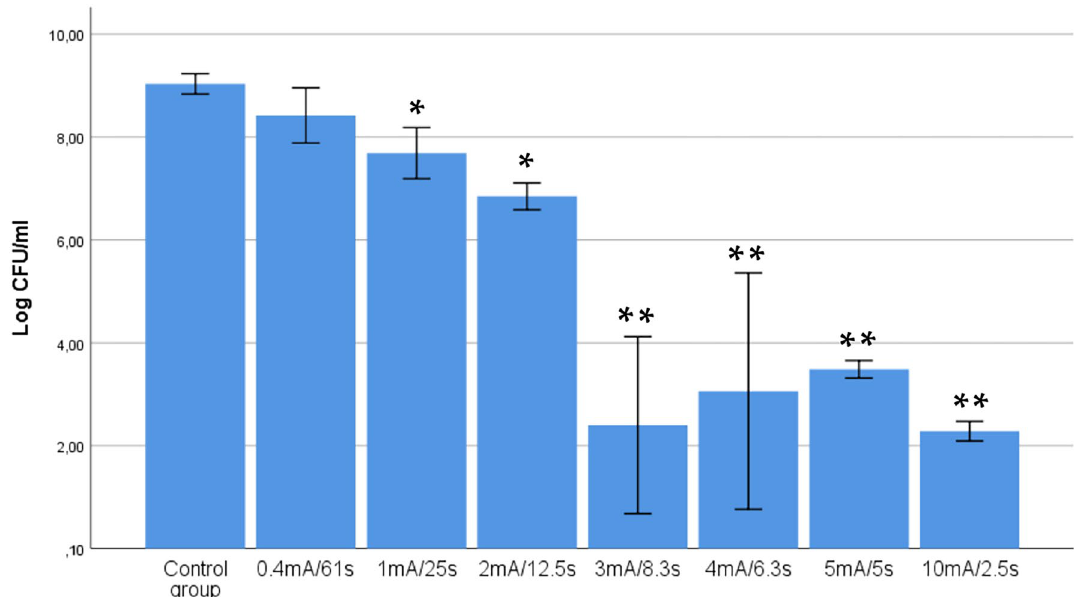
Figure 4. Relevance of the intensity and time of application of a constant dose of 0.125 C of galvanic currents on the bactericidal effect on S. aureus. 14 G tri-beveled needle (2.2 mm × 50 mm) was used, subjecting the bacterial suspensions to five consecutive impacts with the following treatments: 0.4 mA for 62.5 s, 1 mA for 25 s, 2 mA for 12.5 s, 3 mA for 8.3 s, 4 mA for 6.2 s and 5 mA for 5 s. Data were expressed as mean with CI of the number of viable log 10 CFU/ml. (*: statistical significance p < 0.05 in relation to the control group; **: statistical significance p < 0.001 in relation to the control